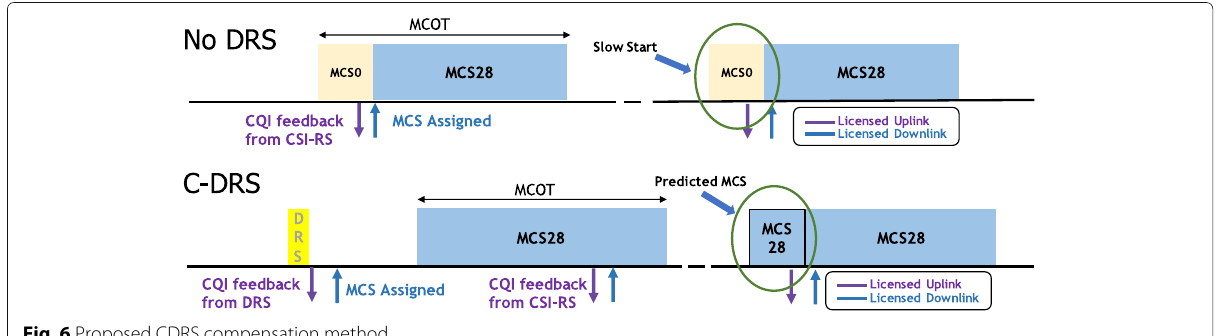
Fig. 6 Proposed CDRS compensation method